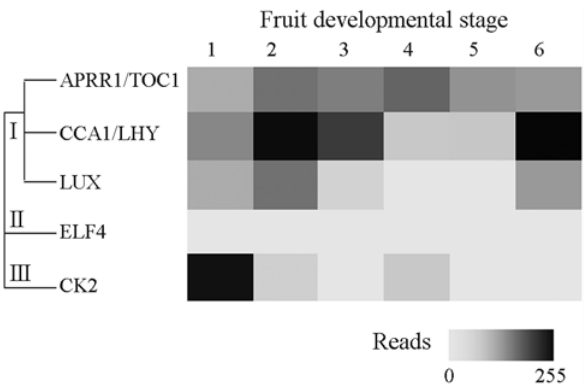
Figure 3 - In silico expression profile of the components of the central os- cillator mechanism of the endogenous clock in citrus. The normalized number of reads for the transcripts in each library is represented as a grayscale. Fruit developmental stage libraries are represented as columns. Hierarchical clustering of the expression patterns is represented by roman